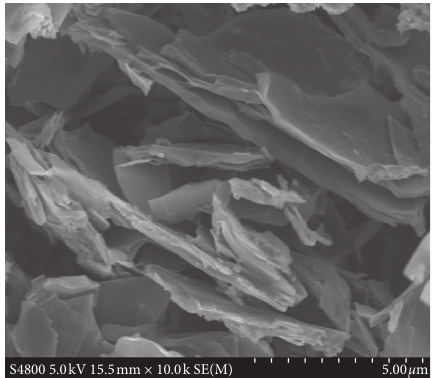
Figure 2: ESEM picture of graphene